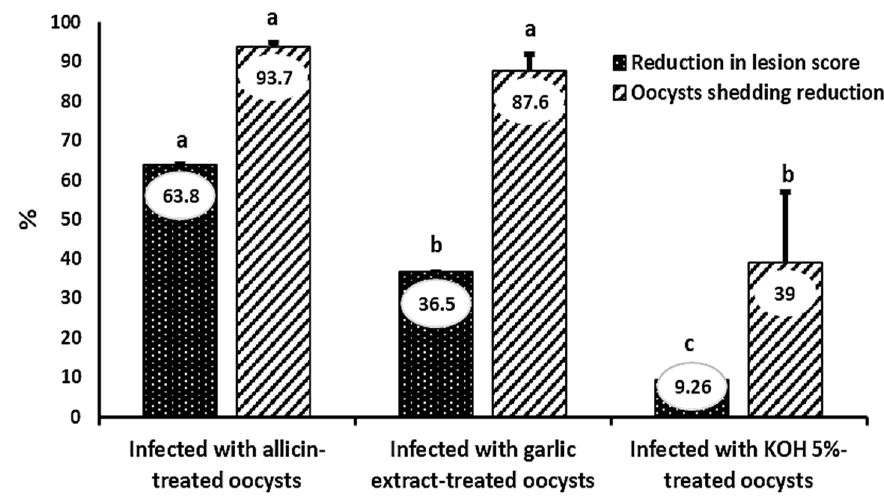
Figure 5. At 7 days post-infection with E. tenella , the percentages of reduction in mean lesion scores and oocyst shedding were calculated. Sporulated E. tenella oocysts in Allicin, alcoholic garlic extract, and 5% KOH. Significant differences exist between columns with different lettering ( p < 0.05). Error bars represent mean ± standard errors of the mean.